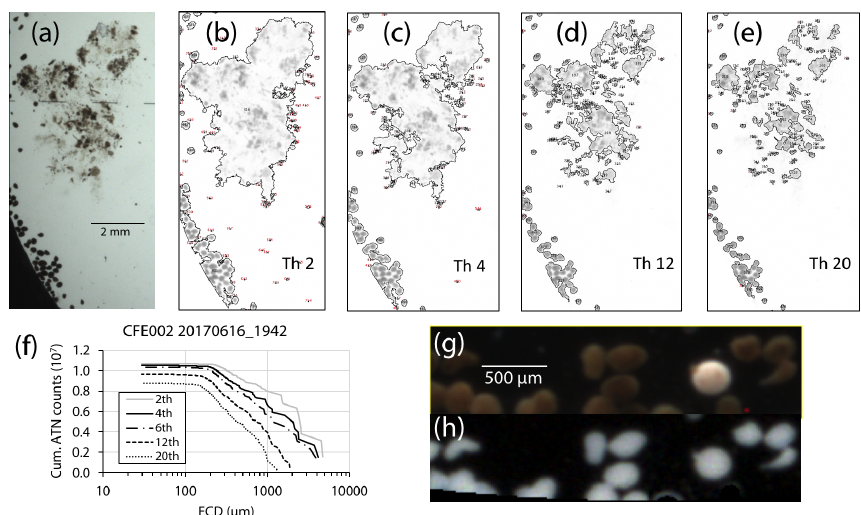
Figure 6. (a) Segment of a CFE-2 transmitted light image June 2017 at 19:42UTC; depth 150m. (b–e) ImageJ particle outline maps at attenuance thresholds of 0.02, 0.04, 0.12, and 0.20, superimposed on the attenuance image for the sample. Darker greys denote higher attenuance. We found that touching faecal pellets could not be separated even at a threshold of 0.20ATN. At thresholds > 0 . 06, large low-density aggregates are seen as highly fragmented, and the contribution of smaller particles is reduced. (f) Particle size attenuance count distributions as a function of threshold. (g) Magnified image under dark-field illumination. Olive-coloured faecal pellets are readily distinguished from an unidentified egg. (h) Attenuance map of the same